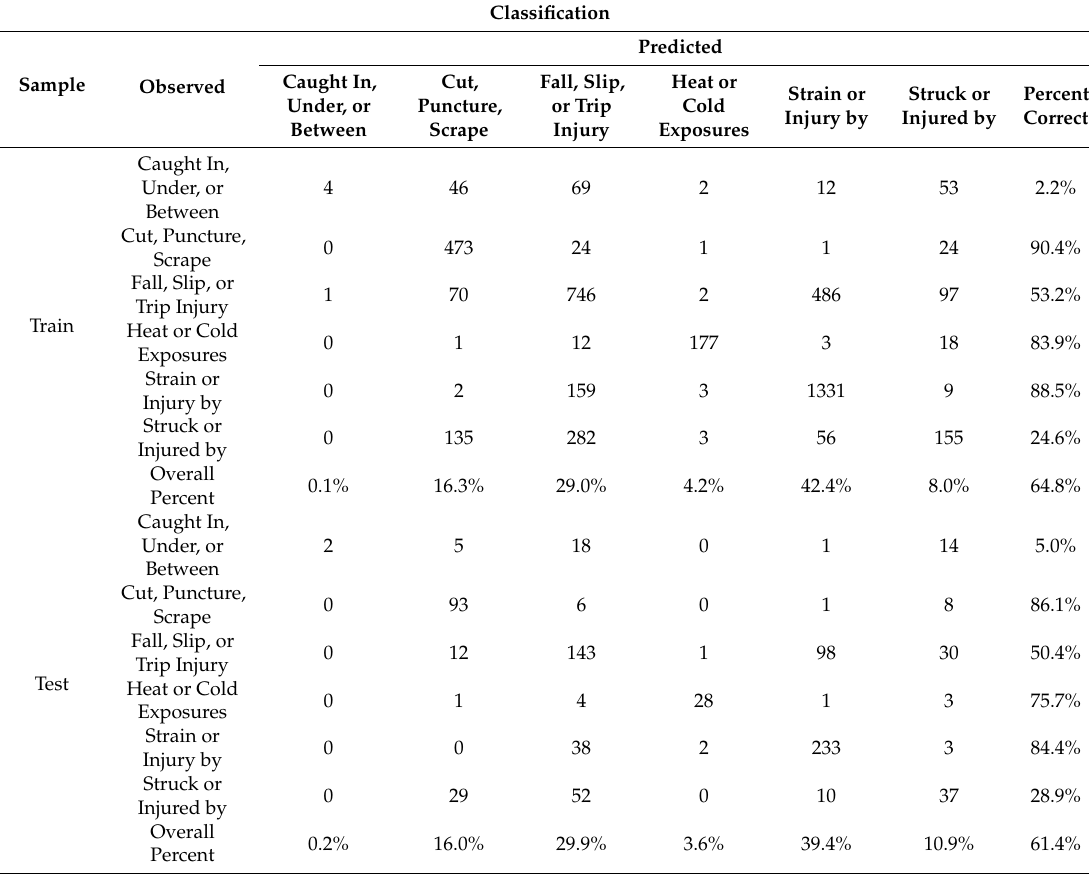
Table 4. Performance of MLP NN Model for Train and Test Data Sets Per Injury Cause Group.